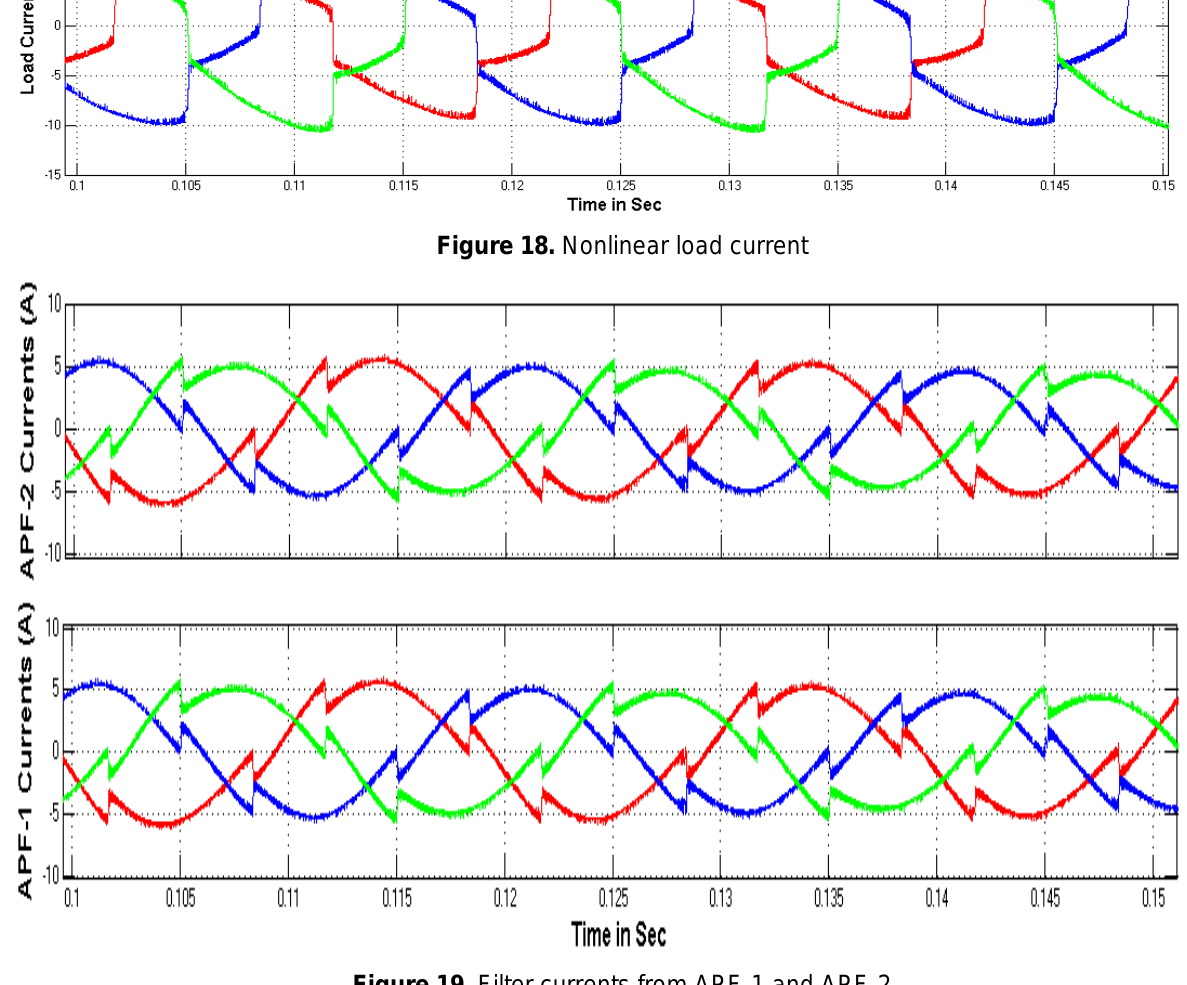
Figure 19. Filter currents from APF-1 and APF-2